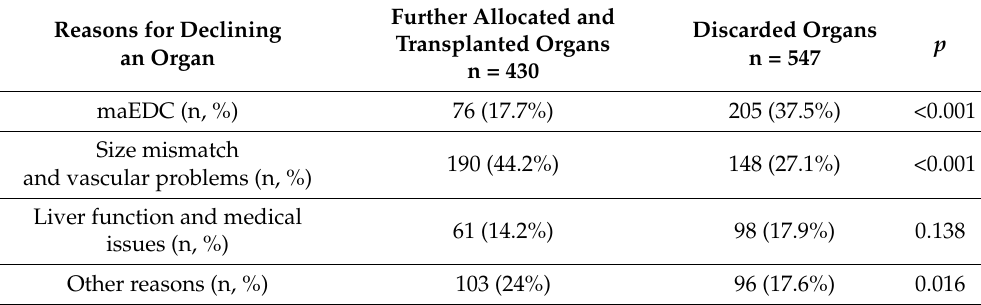
Figure 2. Flow diagram and fate of organs declined because of major extended donor criteria (maEDC; n = 336; 31% of all declined organs). Multiple reasons for declining were possible, and different offers may have been declined for the same reason. CIT, cold ischemia time; maEDC, major extended donor criteria. Table 4. Reasons for declining an organ and comparison between organs that were reallocated and organs that were